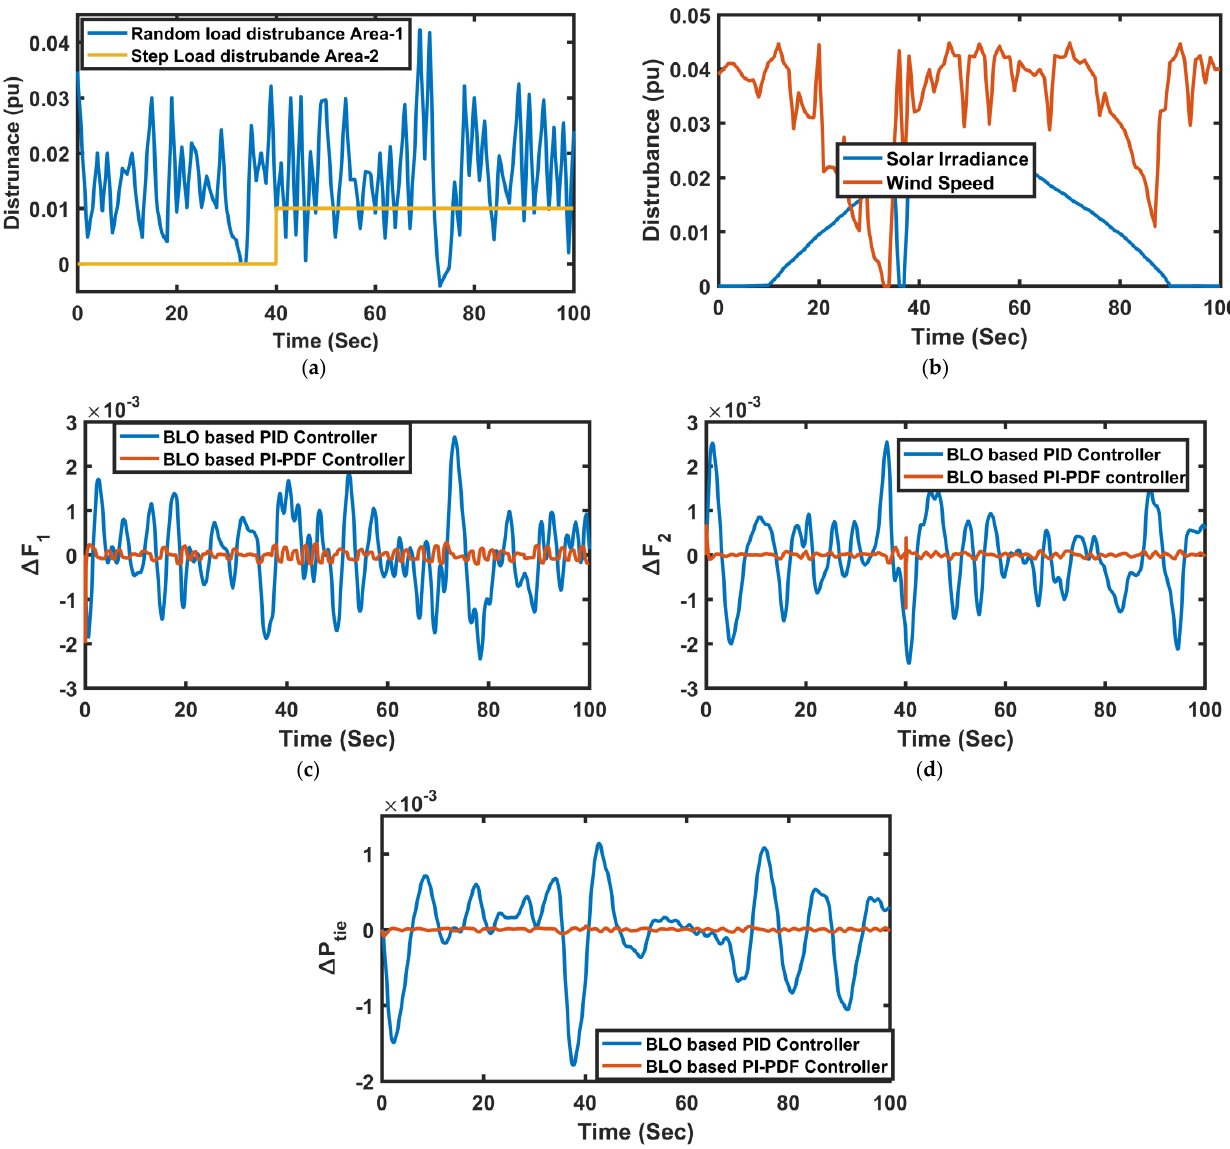
Figure 8. ( a ) Disturbance applied on area-1 and area-2, ( b ) Solar irradiance and wind speed, ( c ) Frequency response of area-1, ( d ) Frequency response of area-2, and ( e ) Tie-Line power response.